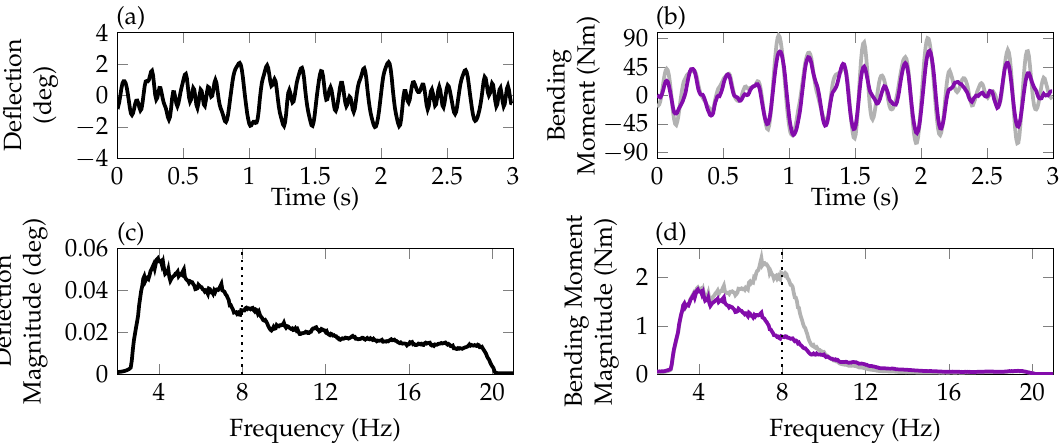
Figure 11. Input and output data for noise excitations in the time domain in ( a , b ) and the frequency domain in ( c , d ). In ( a , c ) the pitch motor noise excitation ( ) is depicted, while in ( b , d ) the open- ( ) and closed-loop ( ) bending moment is